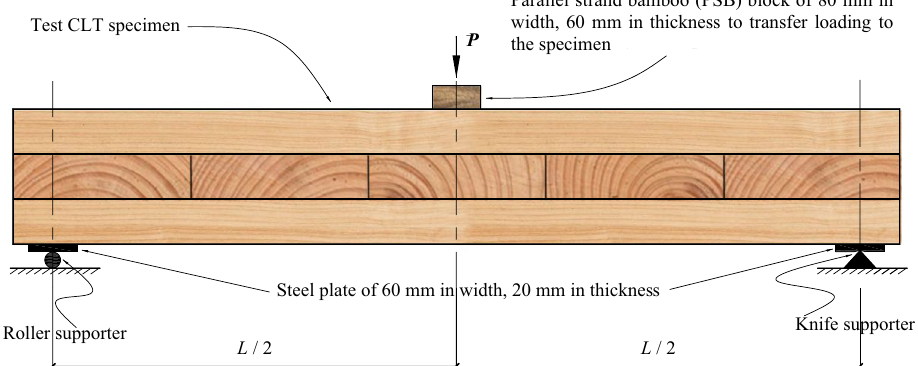
Fig. 4 Test setup of three-point bending of CLT